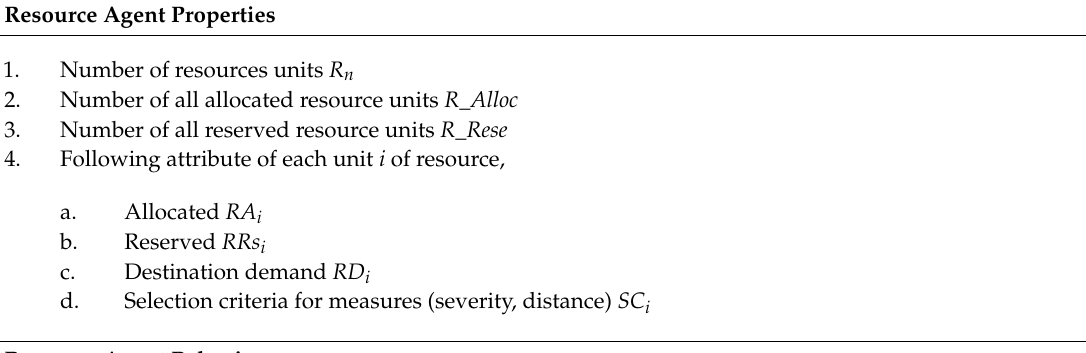
Table 1. Resource agent